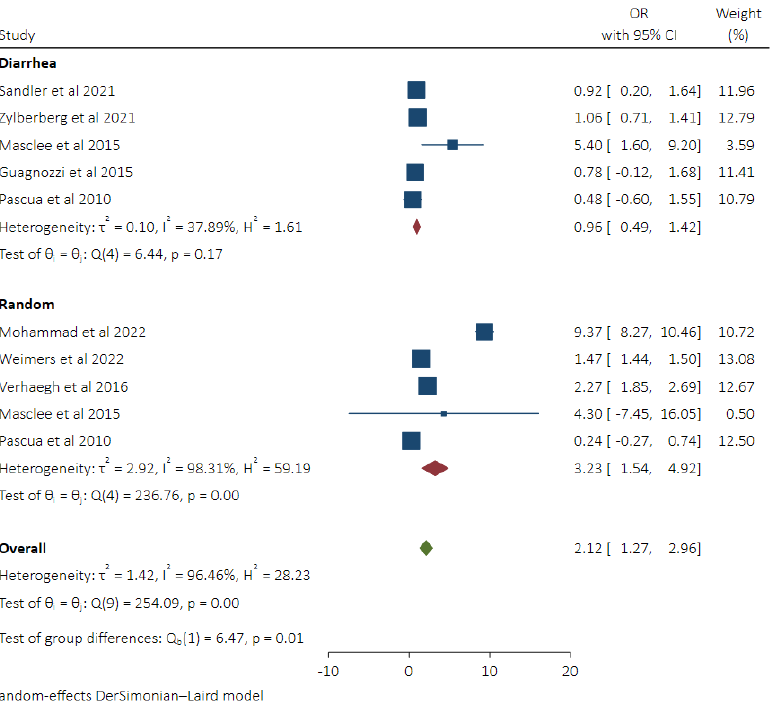
Figure 3. Pooled odds of MC in SSRI users with subgroup analysis based on control groups (Diar- rhea vs. Random Control) [8,9,12,17 –